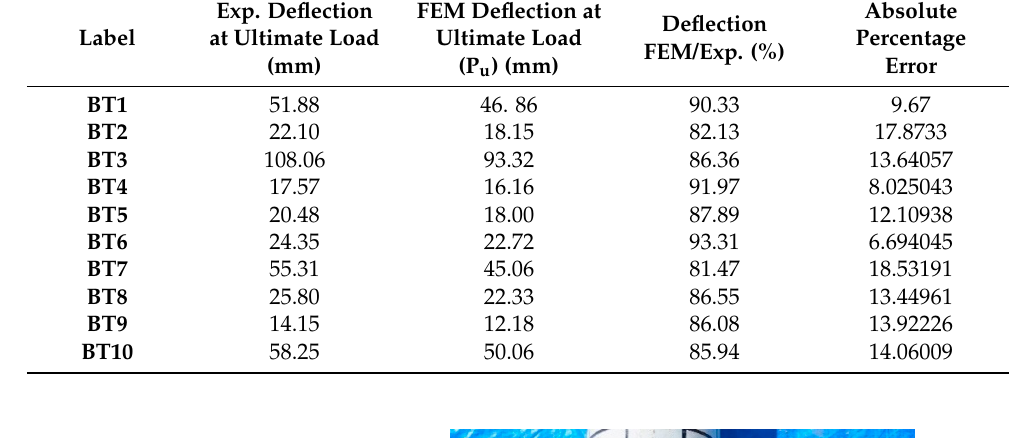
Table 3. Comparison between the experimental and numerical results.